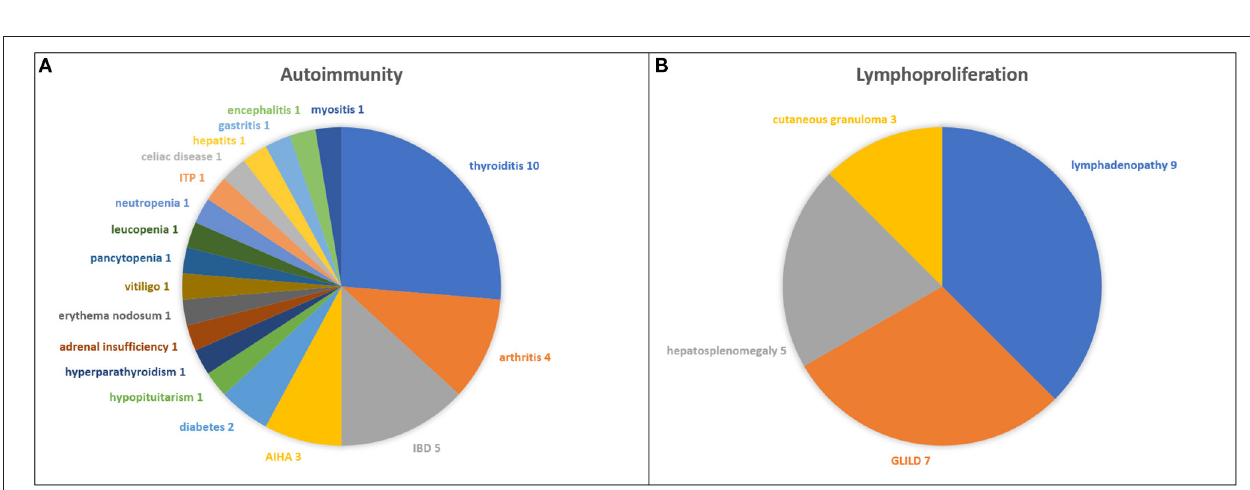
FIGURE 2 | The spectrum of clinical diagnoses and the numbers of CVID children affected with autoimmune (A) and lymphoproliferative (B) disorders.